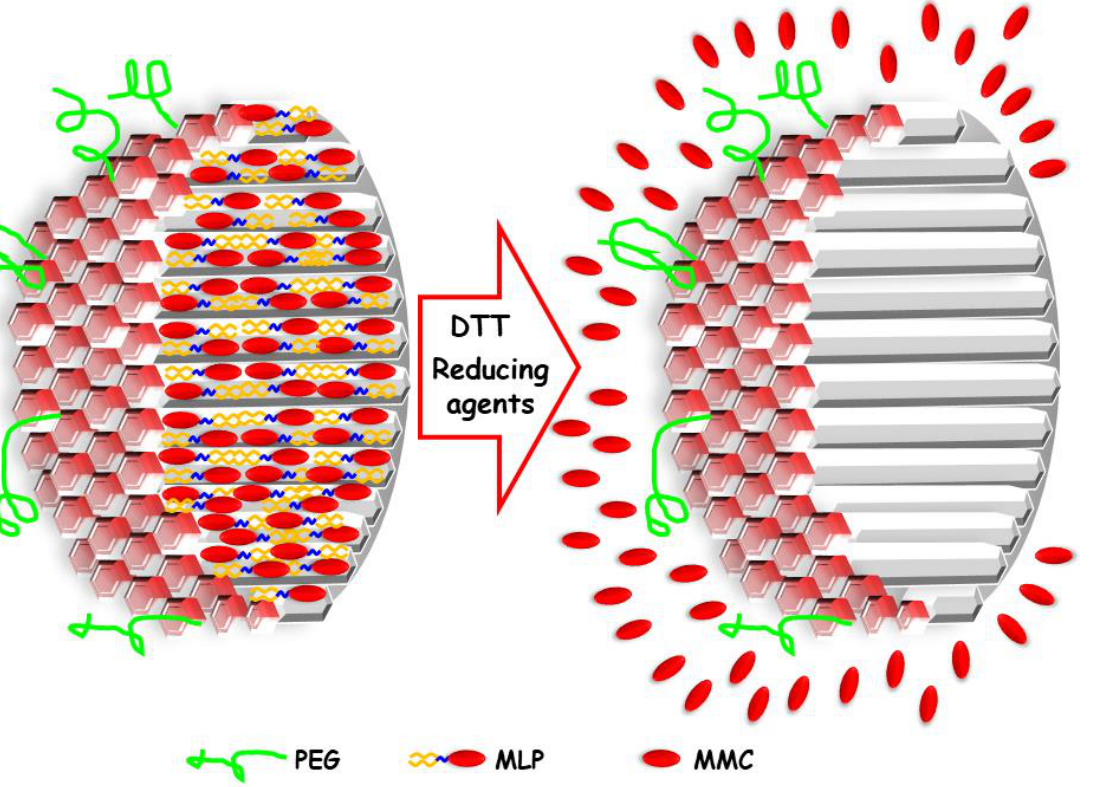
Figure 2. Schematic representation of a cross-section of pegylated MSNPs loaded with the prodrug MLP ( left ); in the presence of reducing agents present in tumor tissues, MMC is released through the cleavage of the disulfide groups ( right ).